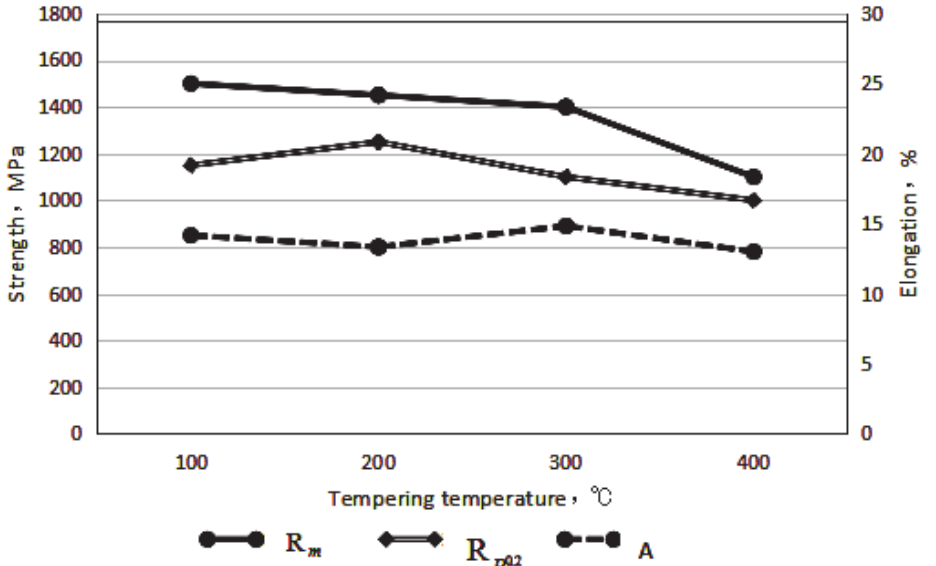
Figure 1: Vibration tendency of the mechanical performance of the experimental materials along with tempering temperature.